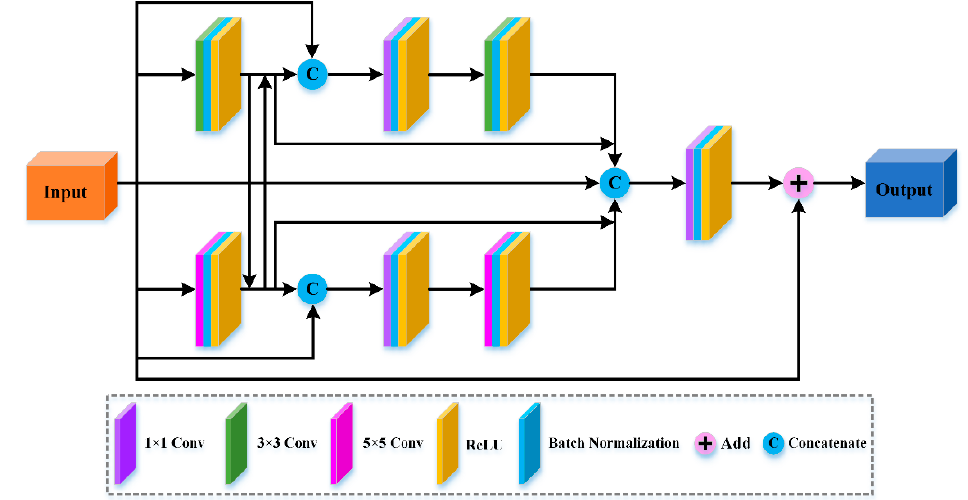
Figure 2. The structure of the symmetrical feature extraction block (SFEB).